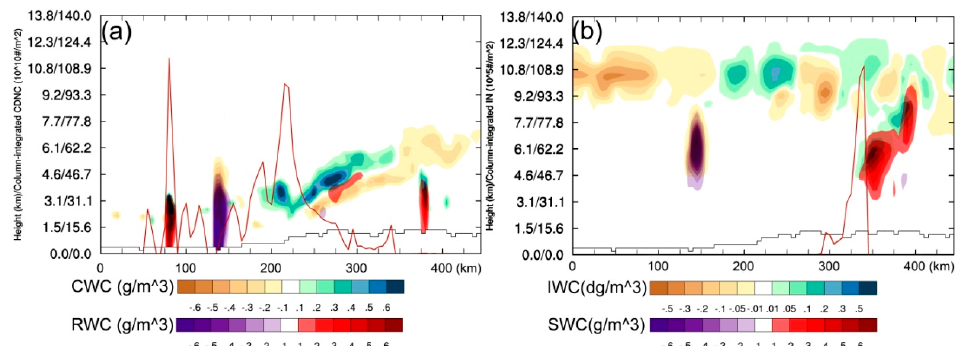
Figure 6. Smoke-induced changes in microphysical properties (SMOKE-CLEAN) along cross sections for 0600 UTC 10 August. ( a ) Differences in CWC (g/m 3 , brown-green), RWC (g/m 3 , purple-red), and column-integrated CDNC (red lines); ( b ) difference in IWC (dg/m 3 , brown-green), SWC (g/m 3 , purple-red), and column-integrated IN (red lines). Black lines indicate terrain height. CWC, cloud water content; RWC, rain water content; CDNC, cloud droplet number concentration; IWC, ice water content; SWC, snow water content; IN, ice nuclei. On 10 August 2002, according to the SRB dataset, values of SW TOA ↑ behind (to the west of) FS1 are around 250–450 W/m 2 . These fairly high values are due to the presence of stratocumulus clouds